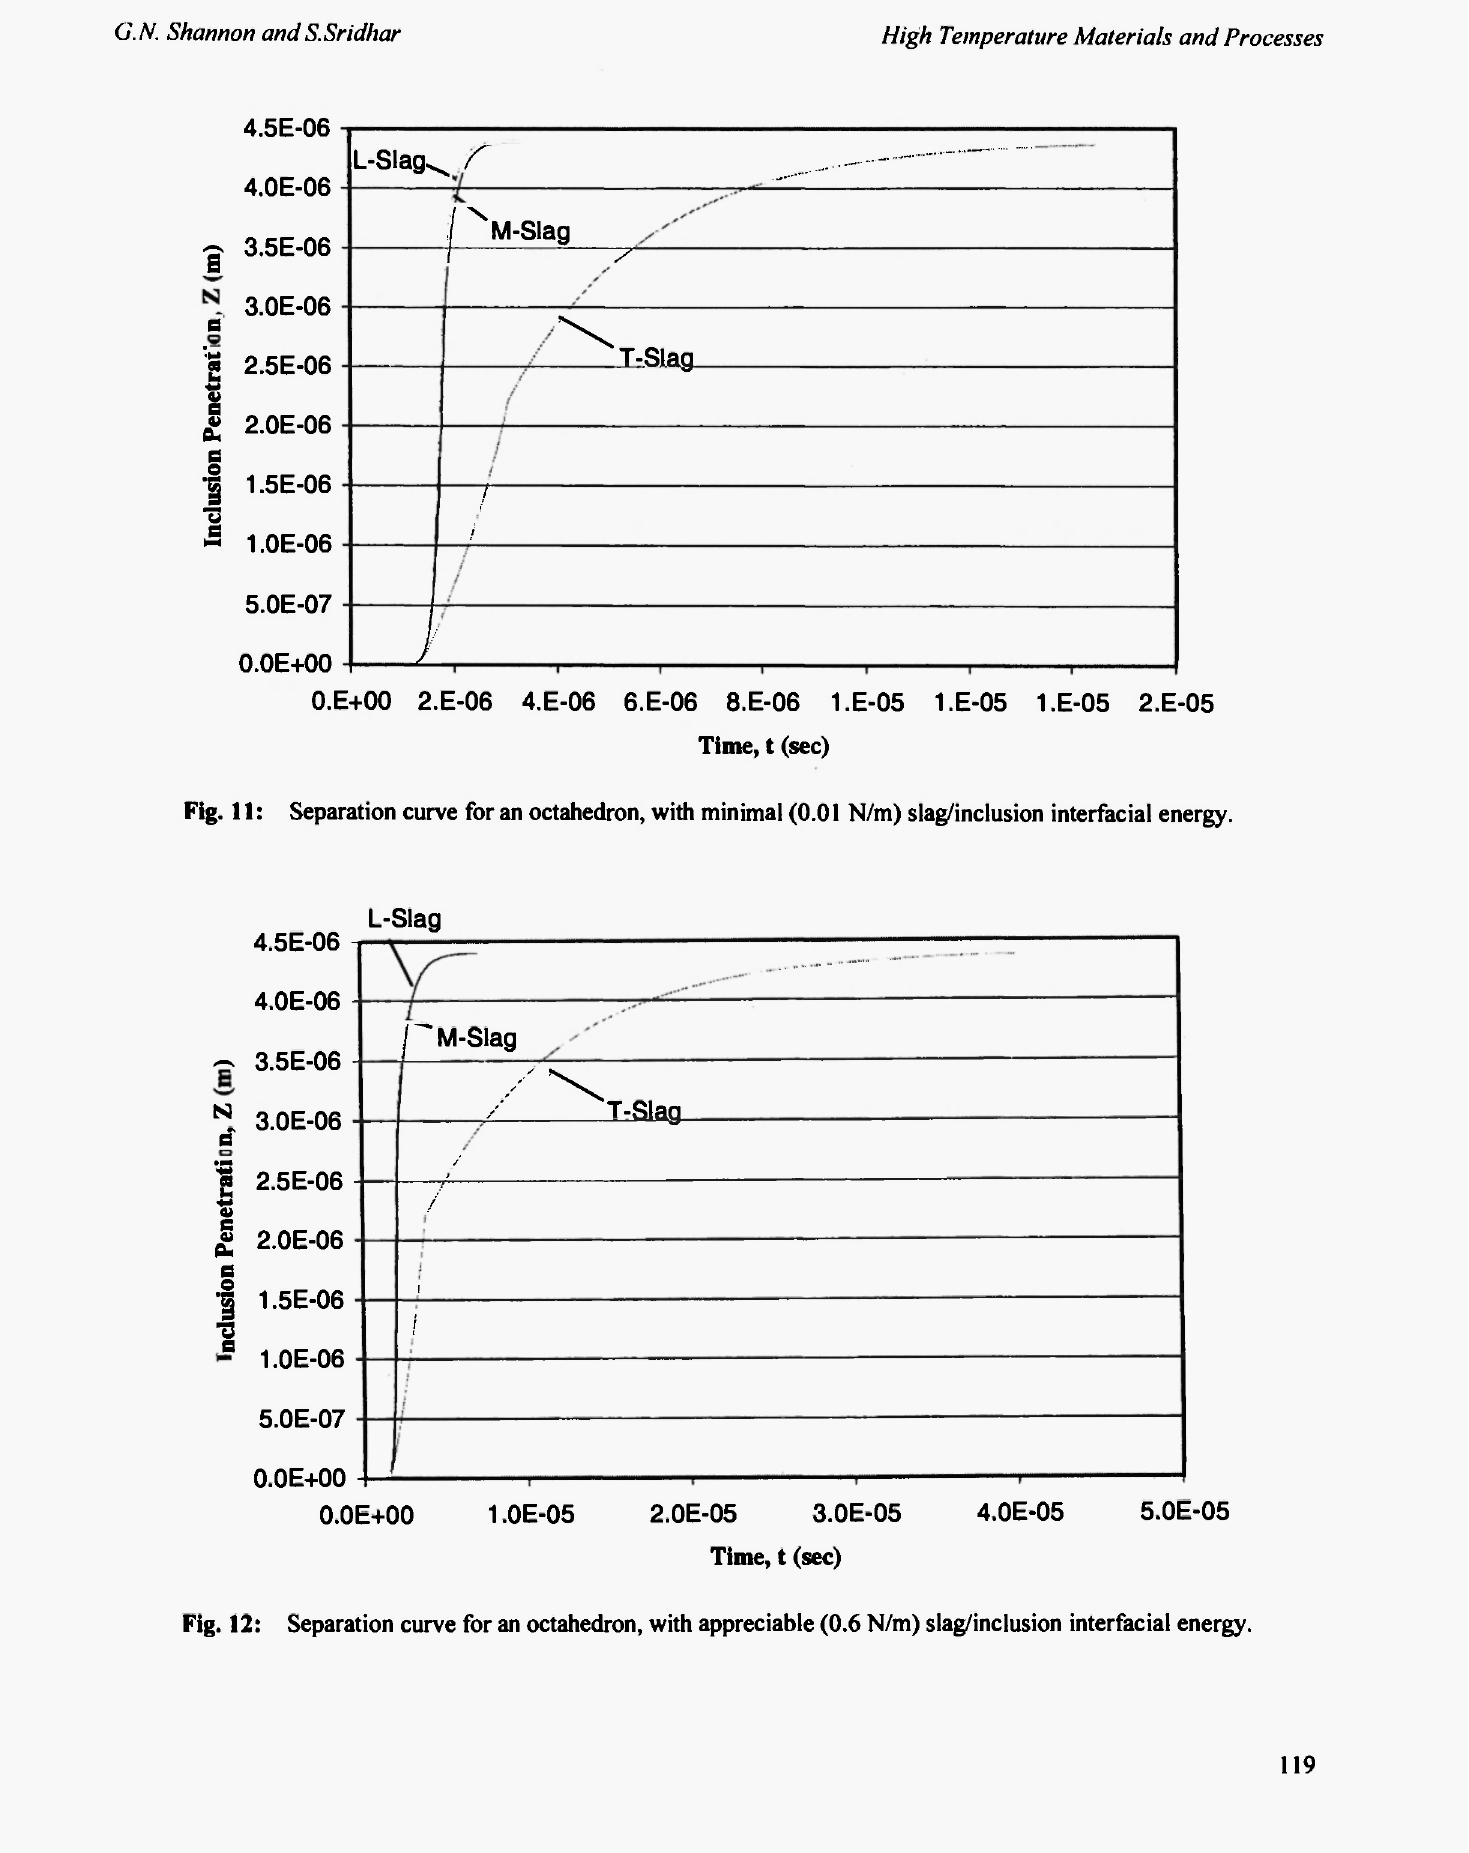
Fig. 12: Separation curve for an octahedron, with appreciable (0.6 N/m) slag/inclusion interfacial